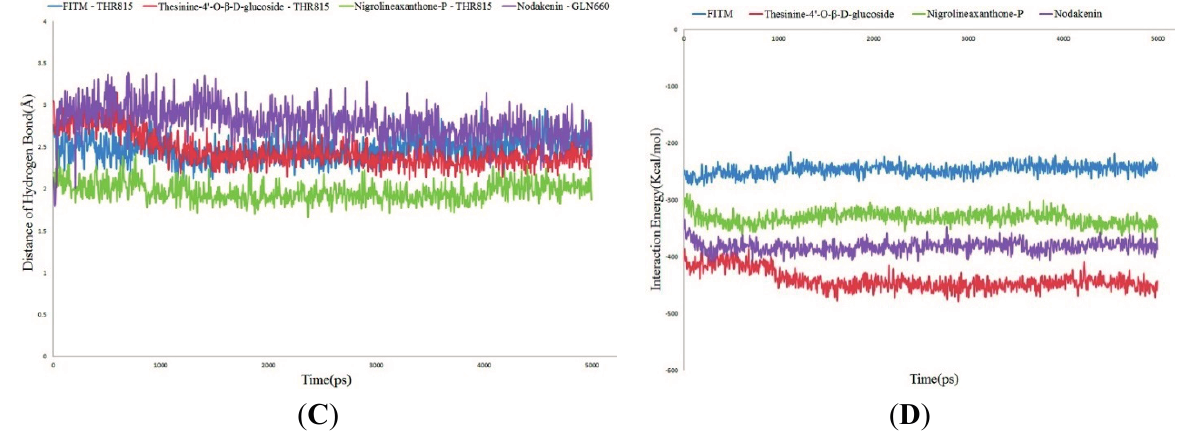
Figure 6. Results of the MD simulation of four complexes. ( A ) Average backbone RMSD; ( B ) Potential Energy; ( C ) Distance of hydrogen bond; ( D ) Interaction energy. Blue indicates FITM, red indicates thesinine-4 ʹ - O - β - D -glucoside, green indicates nigrolineaxanthone-P, and purple indicates